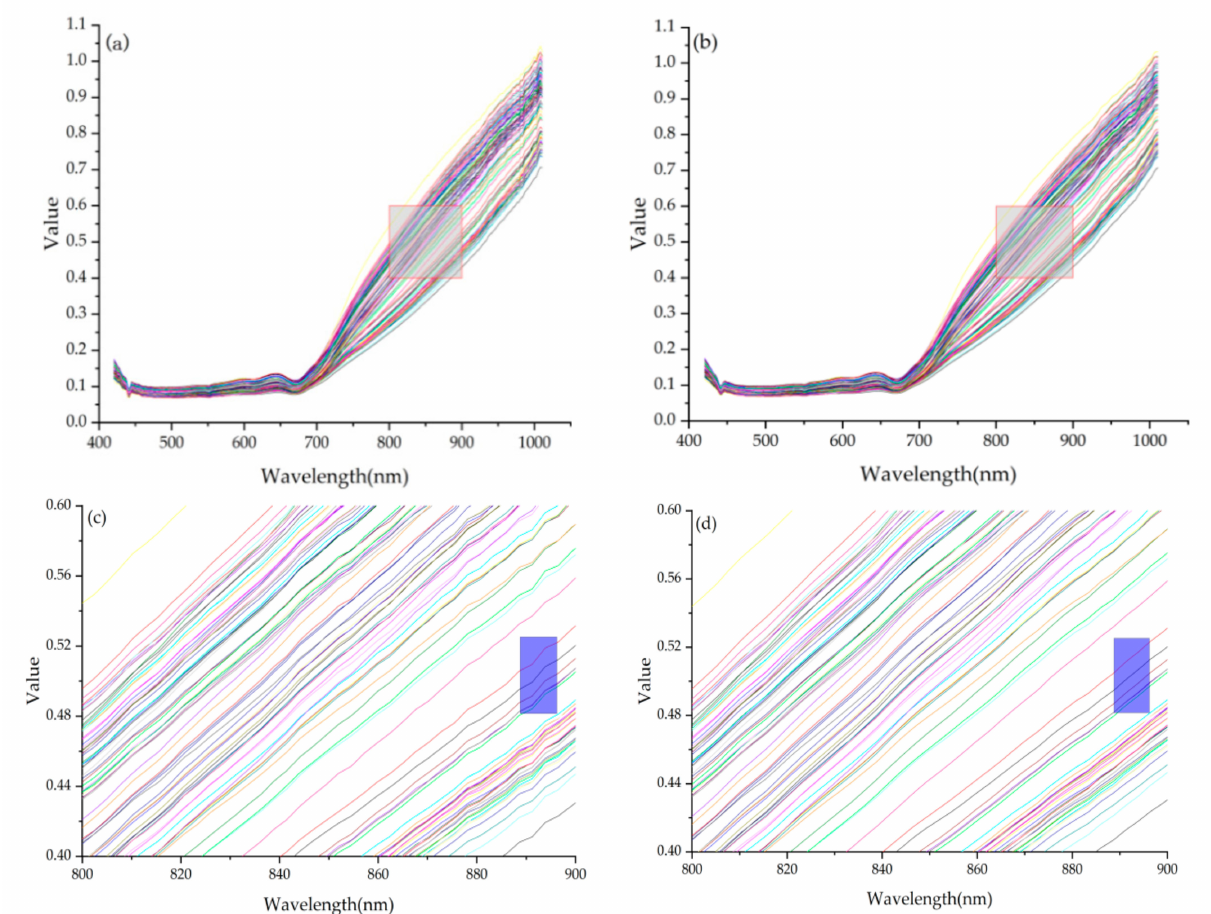
Figure 3. Tibetan tea spectrum curve. ( a ) Raw data; ( b ) Data preprocessed by SG algorithm; ( c ) Enlarged view of the red frame in Figure ( a ); ( d ) Enlarged view of the red frame in Figure ( b